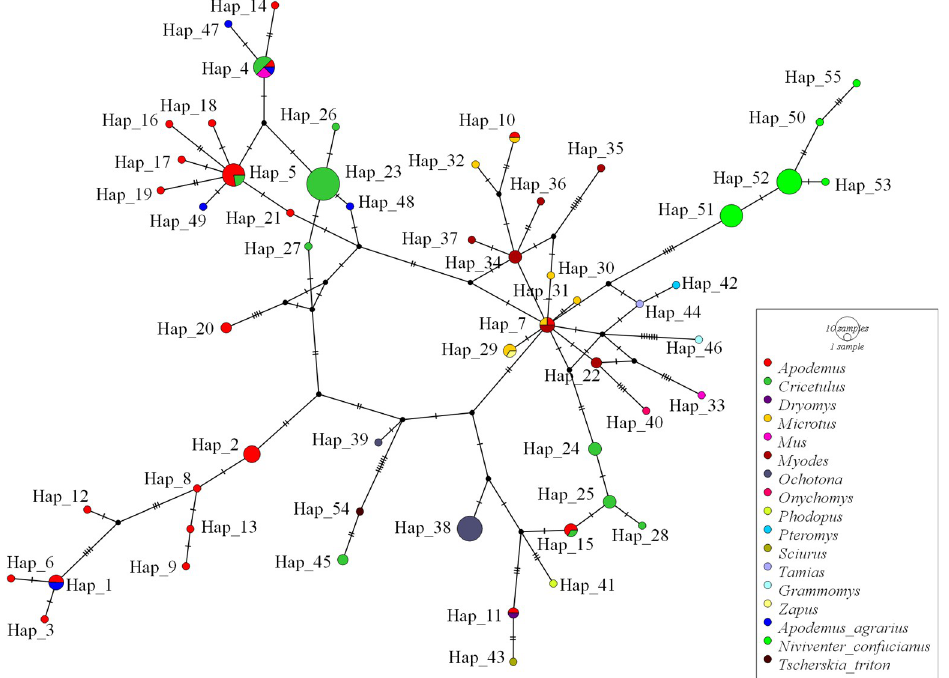
Fig 5. Median-joining networks of gltA gene for B . grahamii sequences from Shangdang Basin and other B . grahamii isolates from different rodents and regions. The sequences were analyzed based on a median-joining network using the Population Analysis with Reticulate Trees (PopART) software version 1.7 (http://popart.otago.ac. nz/index.shtml) with the default setting (epsilon =